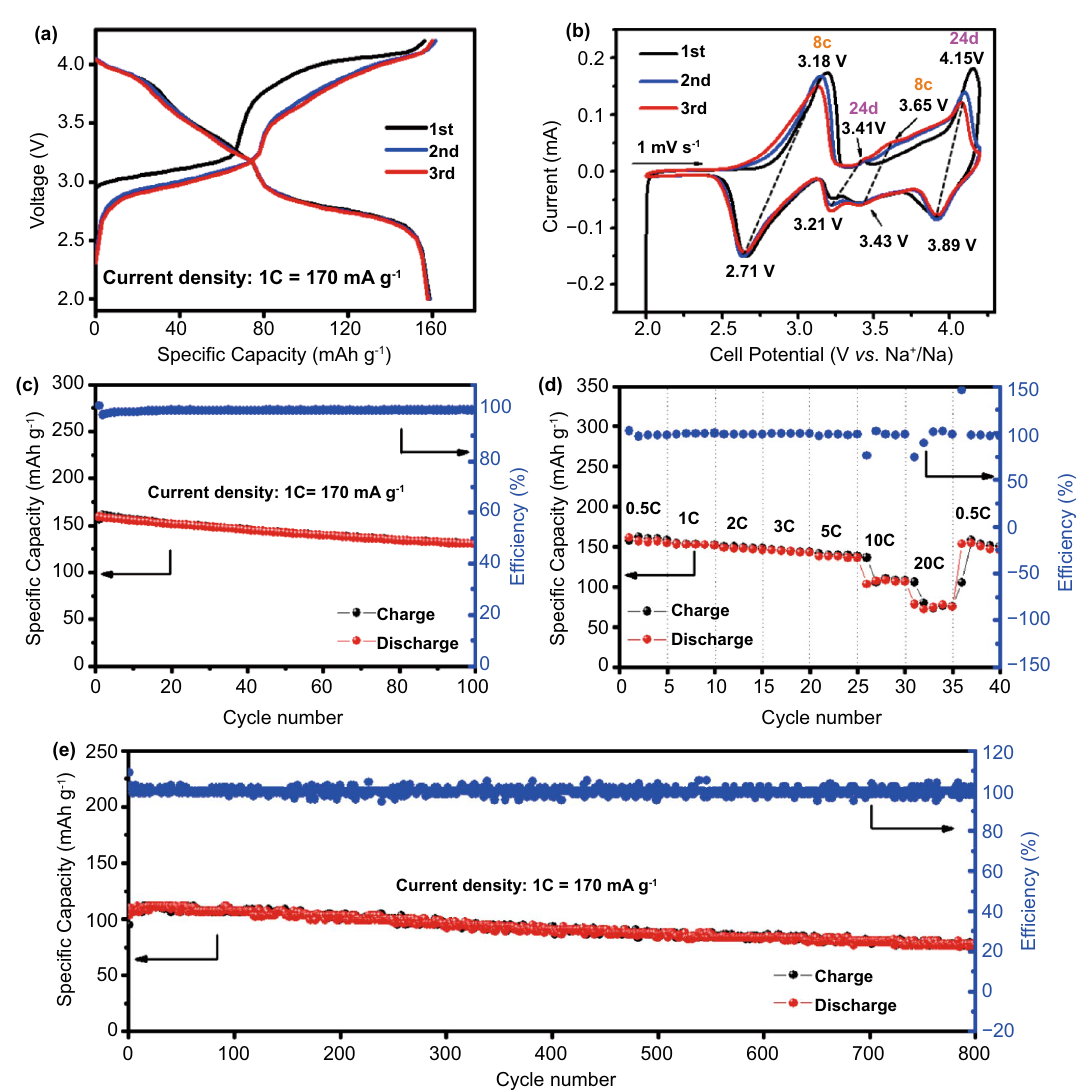
Fig. 5 Electrochemical properties of FeHCF-I. a Charge–discharge curves at 1 C. b CV curves. c Cycling performance at 1 C. d Rate perfor- mance at current densities from 0.5 to 20 C. e Cycling stability at 10